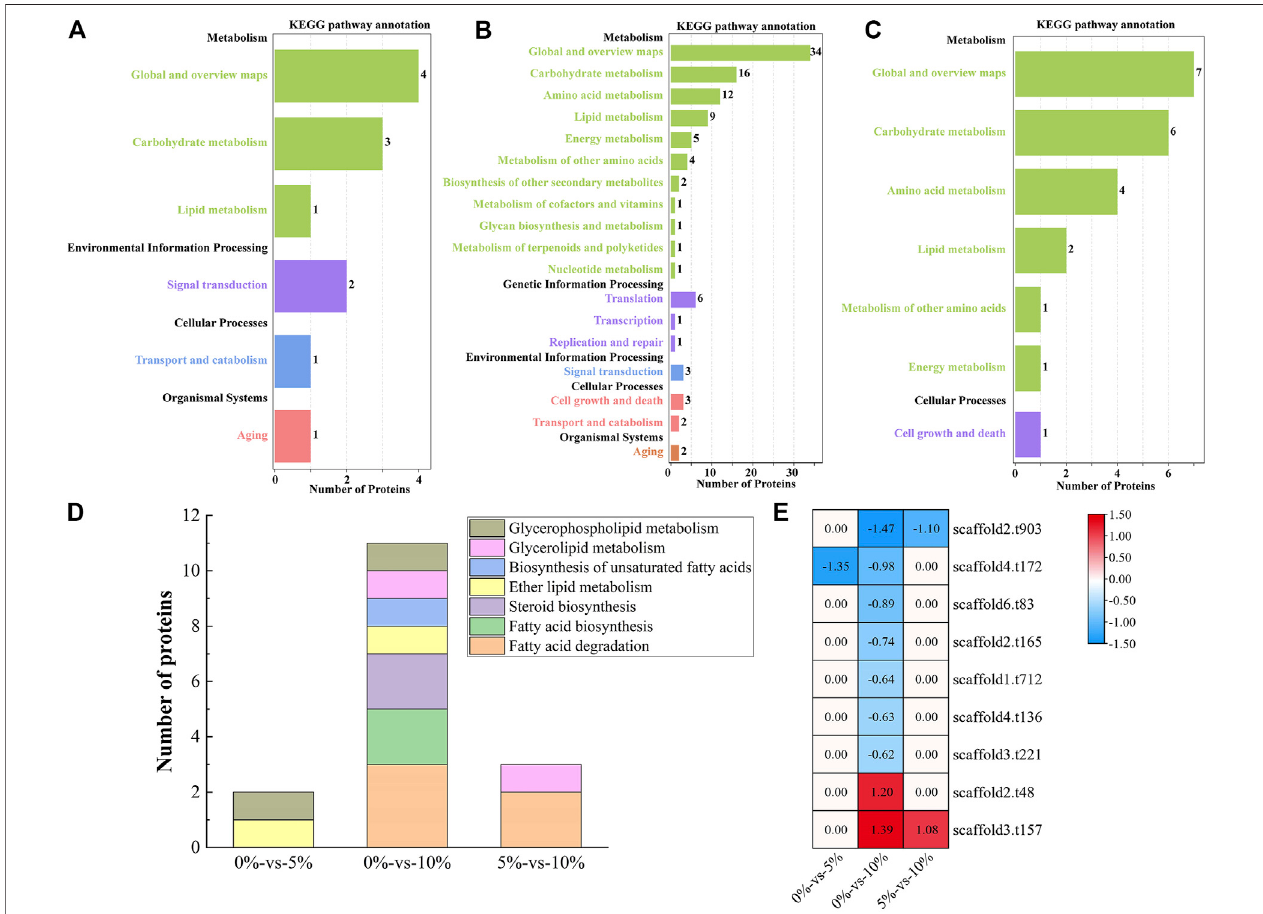
FIGURE 4 | Association analysis of multi-omics data relevant to lipid metabolism. (A) Multi-omics association analysis under the condition of 0%-vs-5%; (B) Multi- omics association analysis under the condition of 0%-vs-10%; (C) Multi-omics association analysis under the condition of 5%-vs-10%; (D) KO enrichment of related differentially expressed genes and differentially expressed proteins; (E) Related differentially expressed genes and differentially expressed proteins.